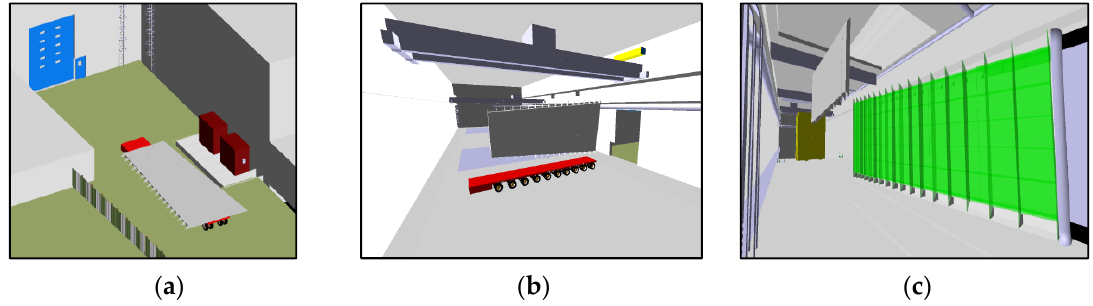
Figure 21. Assembly of the DV as simulated by Navisworks: ( a ) panel transport in the experimental area; ( b ) panel lifting by means of the bridge crane; ( c ) panel assembly at the location of the SHIP detector.